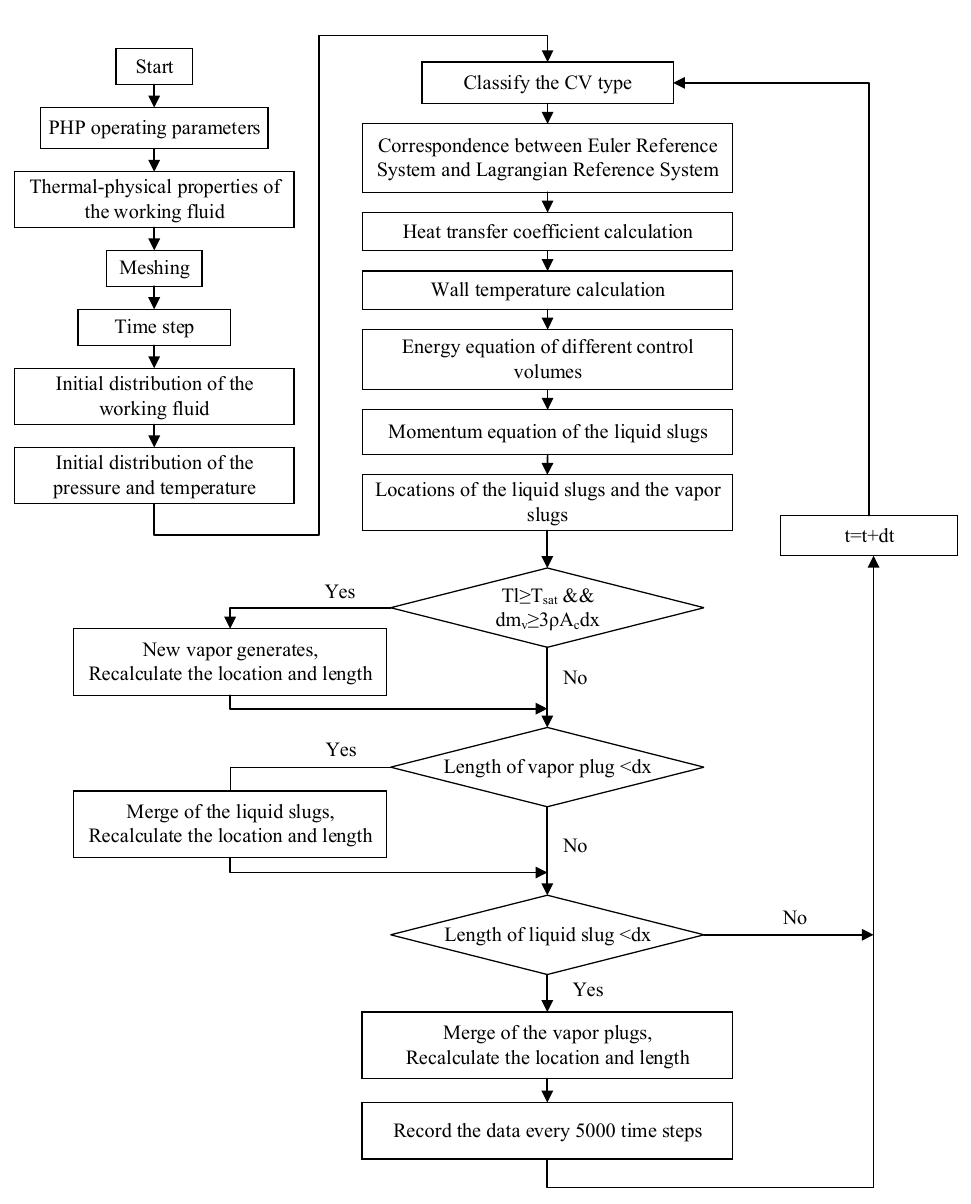
Figure 3. Numerical calculation procedure. Table 3. The input parameters of the numerical